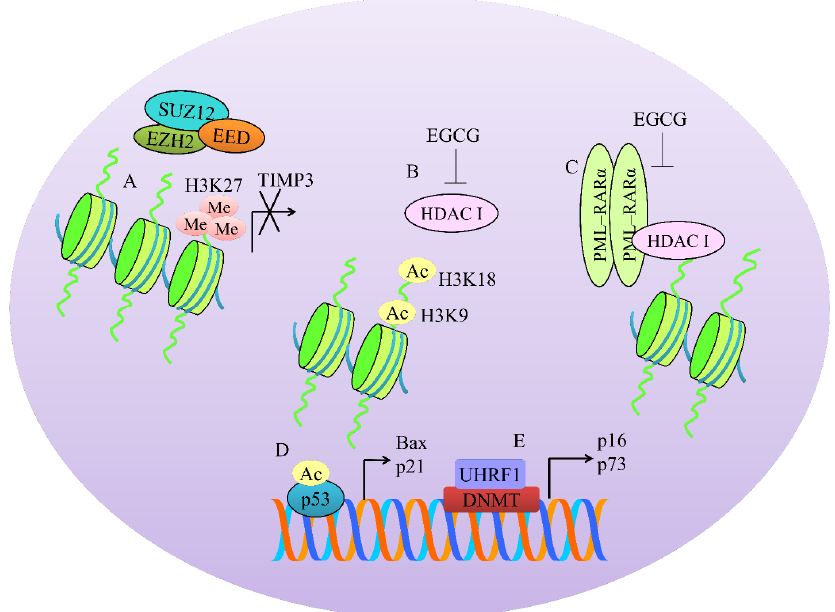
Figure 2. Interconnected and orchestrated interplay among various regulators of epigenetic modifying machinery. ( A ) Protein enhancer of zeste-2 (EZH2), embryonic ectoderm development (EED), and suppressor of zeste 12 (SUZ12) worked synchronously to trimethylate H3K27 and transcriptionally repressed tissue inhibitor of metalloproteinases-3 (TIMP-3). ( B ) Class 1 histone deacetylases (HDACs) were inhibited by EGCG to increase acetylation at H3K9 and H3K18. ( C ) PML–RARα homodimers worked collaboratively with HDAC to regulate expression of target genes. However, EGCG effectively inhibited PML–RARα and HDAC. ( D ) Acetylation of proteins has also been investigated. Acetylated p53 stimulated expression of Bax and p21. ( E ) Ubiquitin-like containing PHD and Ring finger 1 (UHRF1) and DNA methyltransferase (DNMT) also notably downregulated p16 and p73.